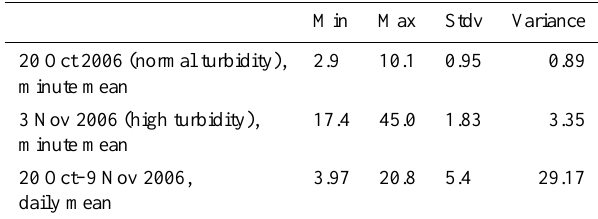
Table 1. Min, max, standard deviation and variance of minute mean data for two of the days shown in Fig. 4, and for daily mean data for the whole period shown in Fig.